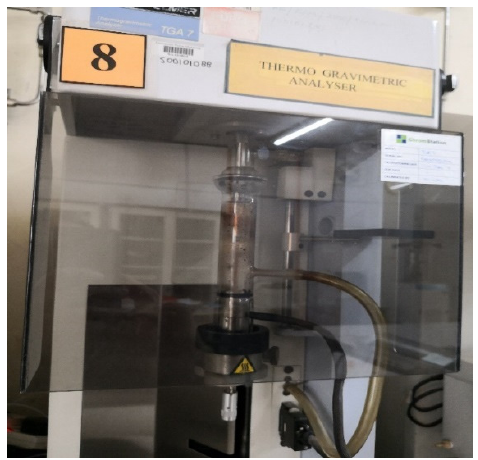
Figure 3. Thermogravimetric analyzer.